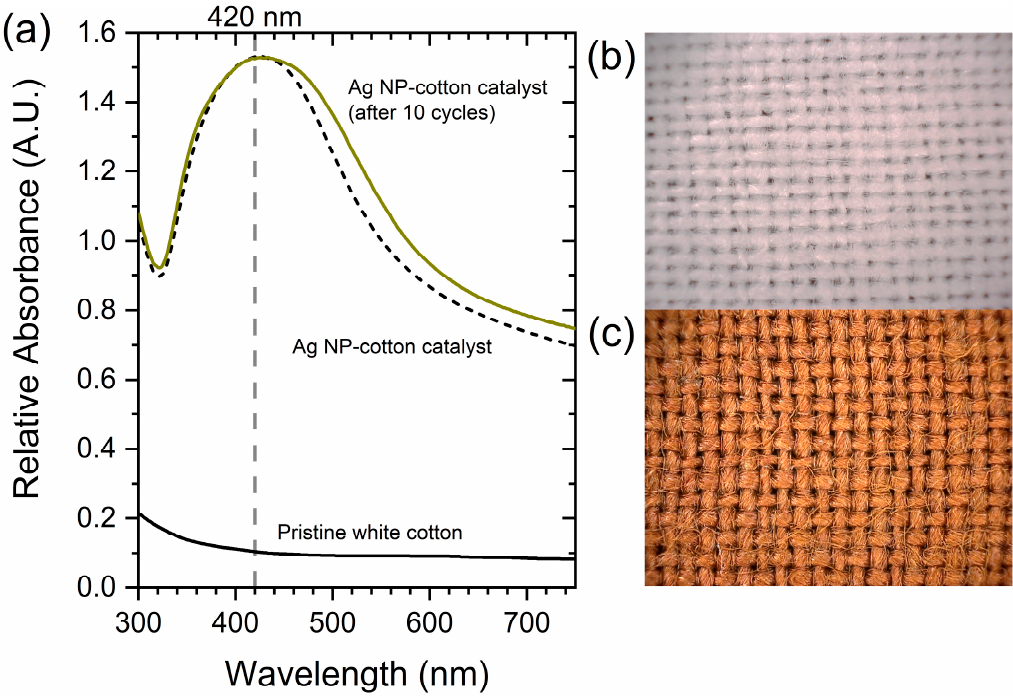
Figure 1. ( a ) UV/vis spectra of pristine white cotton (solid black line), synthesized Ag NP–cotton catalyst (solid yellow line) with maximum absorption at 420 nm, and Ag NP–cotton catalyst after 10 degradation cycles (dotted black line). Digital microscope images at 50× magnification of ( b ) pristine white cotton fabric and ( c ) Ag NP–cotton catalyst fabric.